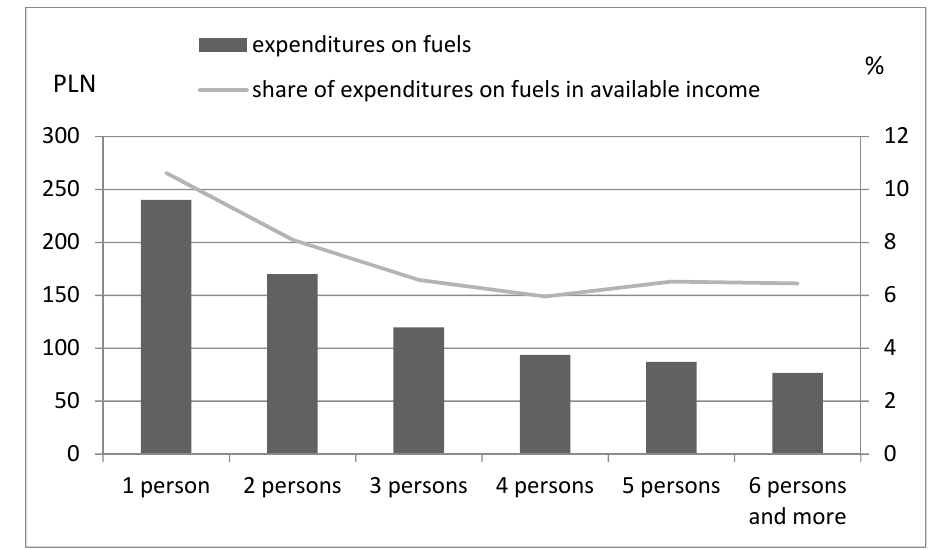
Figure 1. Expenditure on energy carriers and their share in available income by household size in Poland in 2018. Source: own study based on [8].